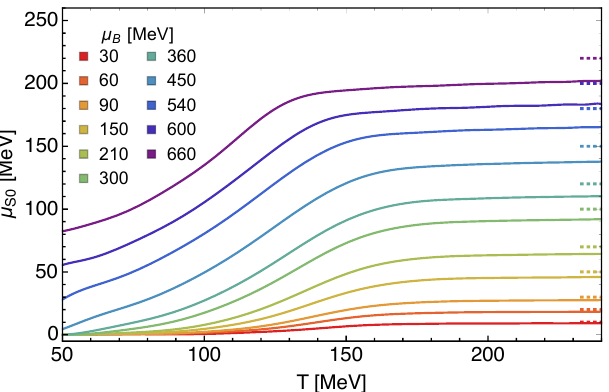
Figure 4: The strange chemical potential as a function of temperature at strangeness neutrality for various baryon chemical potentials. The asymptotic values for free quarks are indicated by the dotted lines at the right edge of the plot. µ from bottom to top.